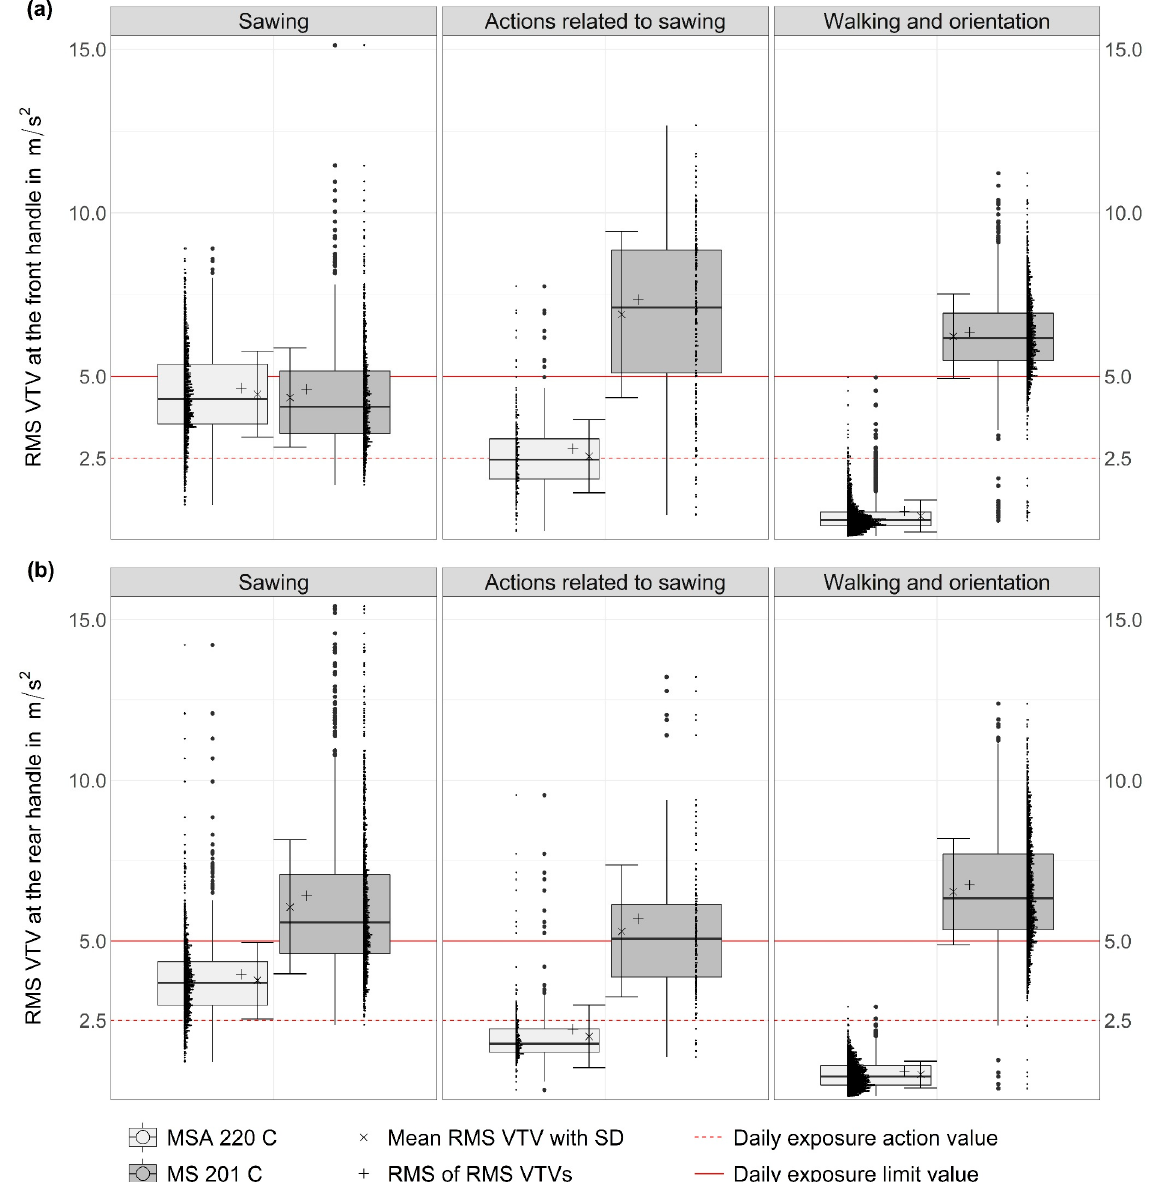
Figure 2. RMS VTVs of both chainsaws separated by the type of activity ( a ) for the front handle ( b ) for the rear handle.